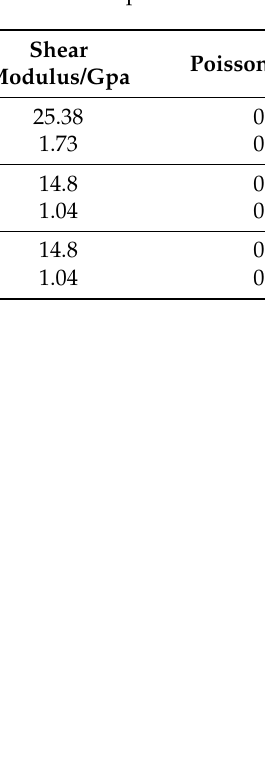
Table 1. Dimensions and mechanical parameters of soil and structural components.